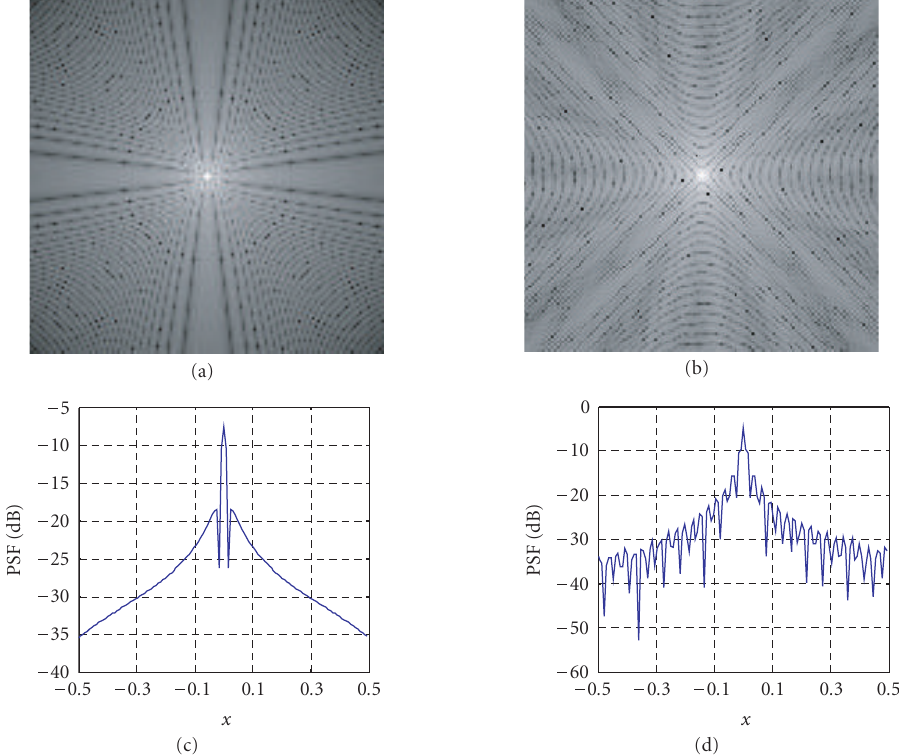
Figure 1: Point spread functions of non-Cartesian sampling functions in dB scale. (a) Radial PSF. (b) Spiral PSF. (c) A center line profile of the radial PSF. (d) A center line profile of the spiral PSF.